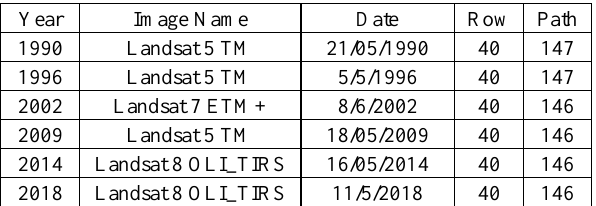
Table1. Satellite data used